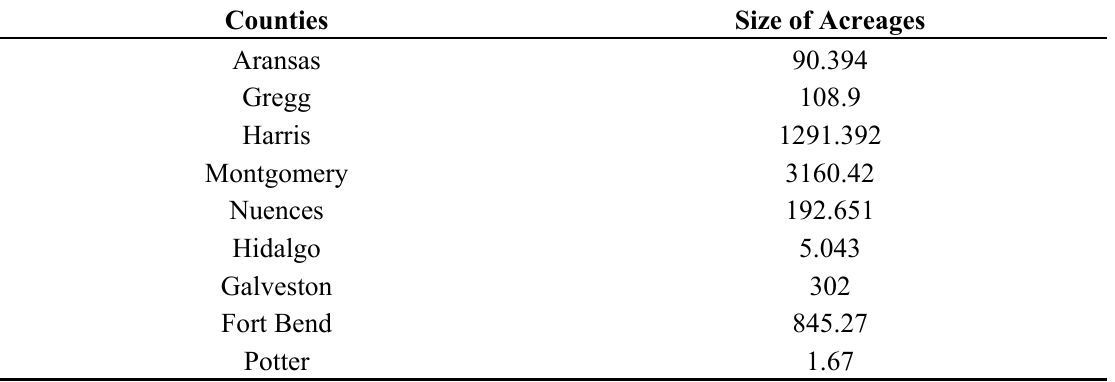
Table 12. Voluntary Clean Up Program in Selected Counties from